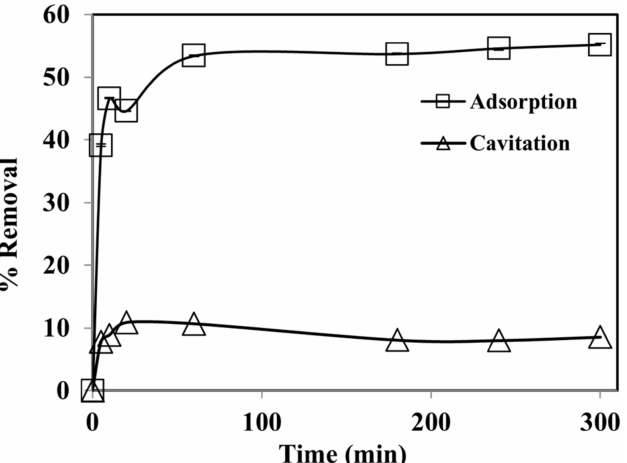
Figure 3. The effect of contact time on phenol removal by adsorption and cavitation processes. Experimental conditions: phenol conc. = 25 mg L − 1 , pH = 3.5; cavitation power = 80 W; adsorbent dose = 800 mg L − 1 ; temperature = 30 ± 2 ◦ C.